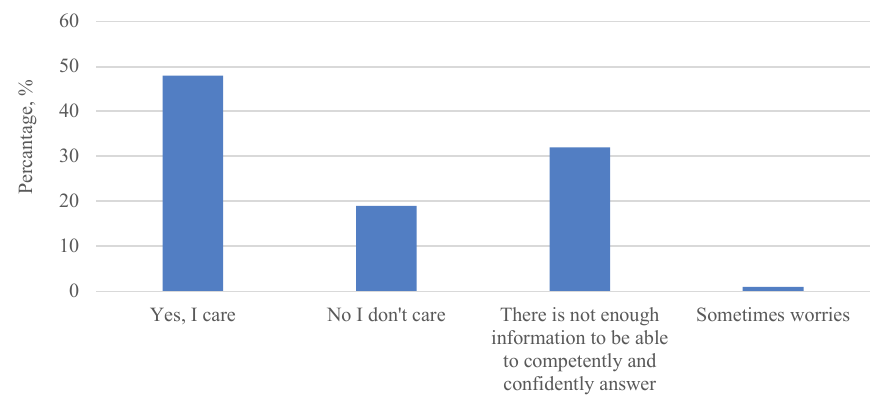
Fig. 3. Answers on the question if the problem of CO 2 emission bothers